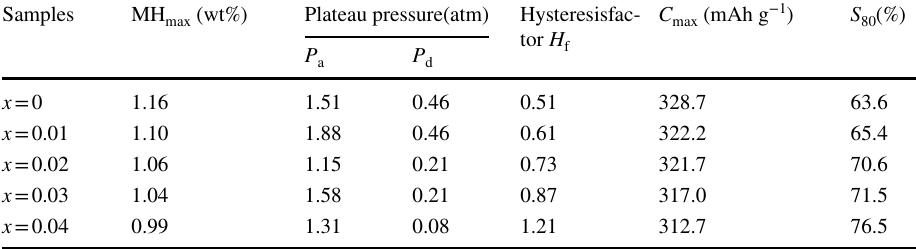
storage characters of the